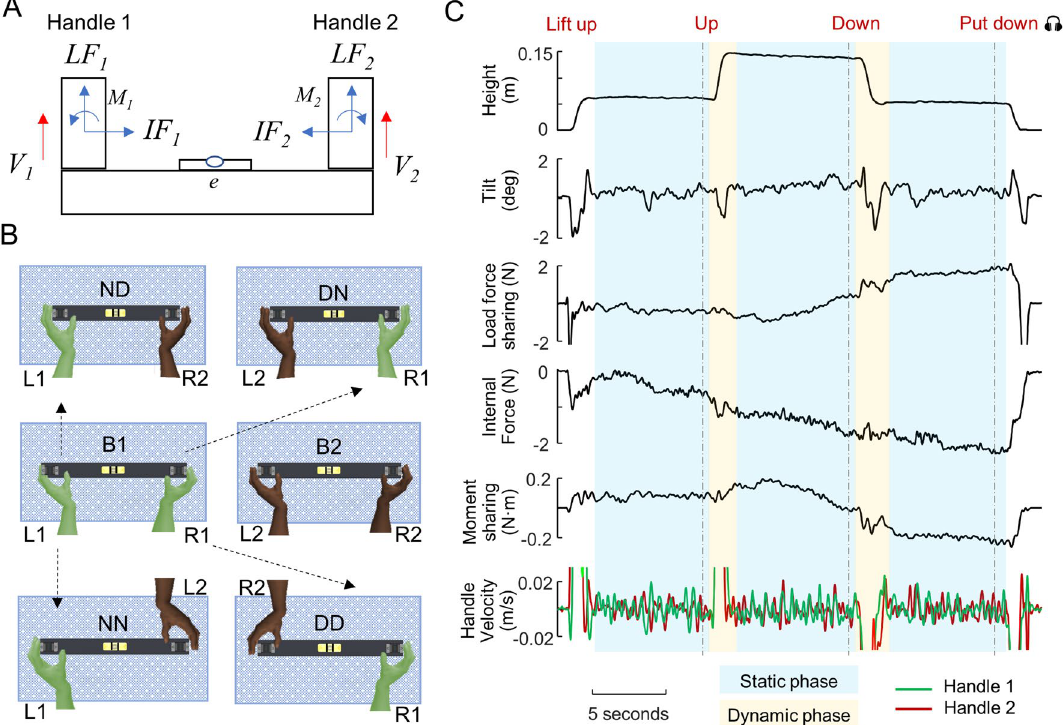
Figure 1. Experimental design and definitions of variables related to coordination. ( A ) We defined behavioral variables with respect to the object to be balanced by two hands. Each hand (from one or two participants) grasped one handle with thumb on the inner portion of the handle. e denotes the tilt angle as indicated by a bubble level. LF i , IF i , M i , and V i are load forces, normal forces, in-hand moments, and handle vertical velocity measured at handle i (1 or 2), respectively. The direction of the arrows represents posititive directions. ( B ) Top view of six different task conditions: bimanual solo (B1 and B2), dyadic different-hand (DN and ND), and dyadic same-hand (DD and NN, respectively). The first and second letters of these acronyms denote the hands used by the participants from B1 and B2, respectively. ( C ) From top to bottom: object vertical position, object tilt (performance error, e ), internal force, load force sharing, in-hand moment sharing, and handle vertical velocities. Dynamic and static phases are denoted by yellow and blue shading, respectively. Data are from one subject pair (DD condition). The timeline of auditory cues is denoted by vertical dashed